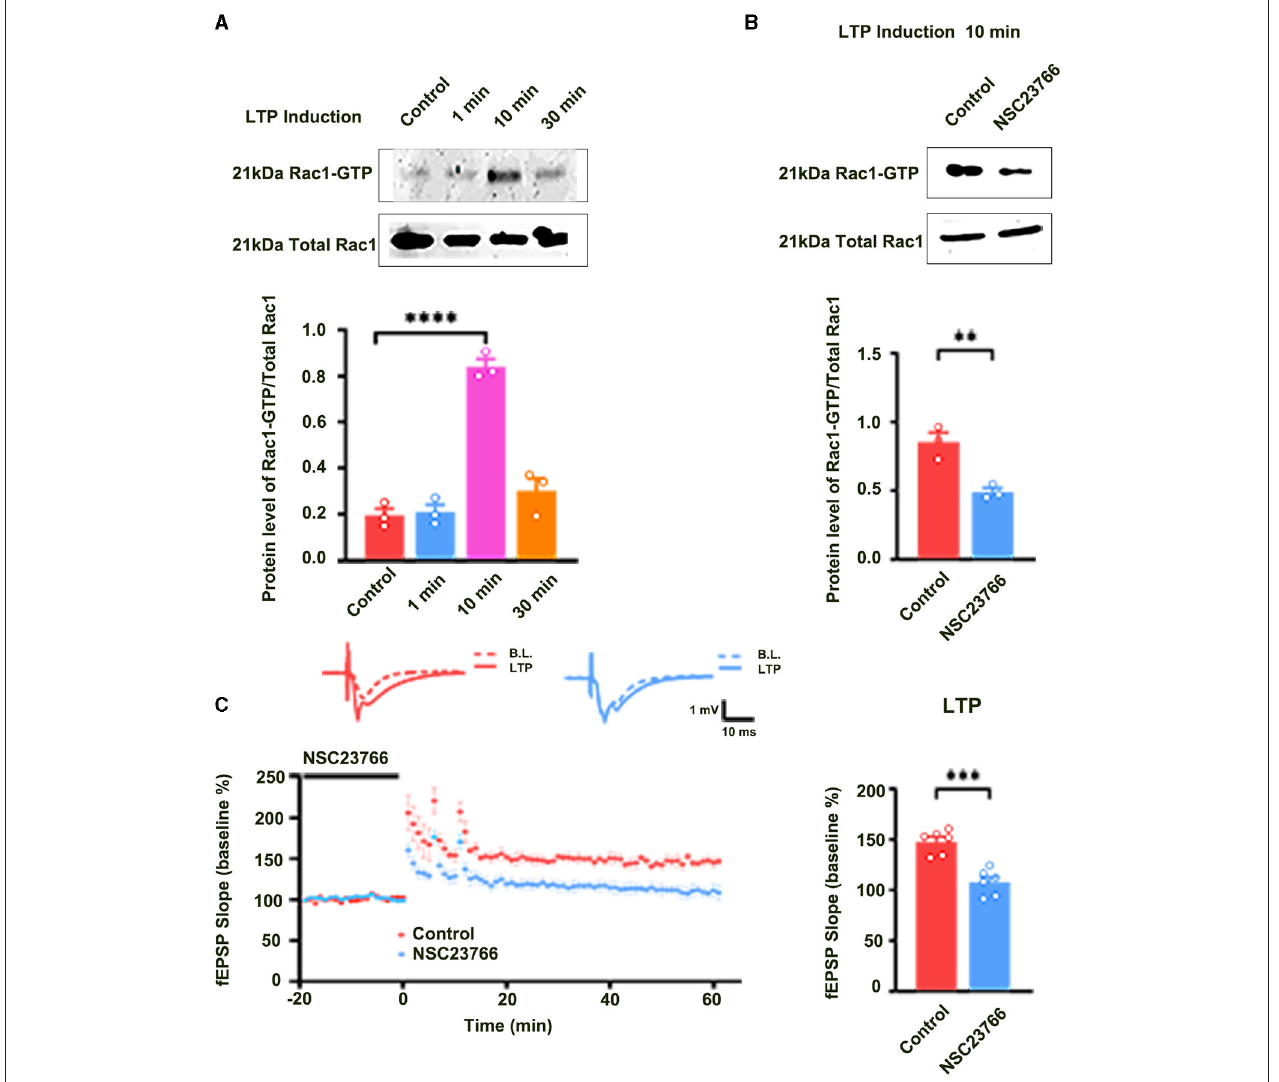
FIGURE 1 | The role of Rac1 in LTP induction. (A) Influence of three trains of HFS on Rac1 activation (one-way ANOVA, **** P < 0.0001, n = 3 in each group). (B) Influence of Rac1 antagonist NSC23766 (100 µ M) on Rac1 activation at 10min after HFS (unpaired t- test, ** P < 0.01, n = 3 in each group). (C) Influence of Rac1 antagonist NSC23766 (100 µ M) on LTP induction (unpaired t- test, *** P < 0.001, n = 6 in each group). Top: Typical fEPSP trace at baseline and during LTP recordings. Left: LTP was recorded for 1h after three trains of HFS. Right: Average fEPSP slope during the last 15min of the LTP recording. All data are shown as mean ± SEM.